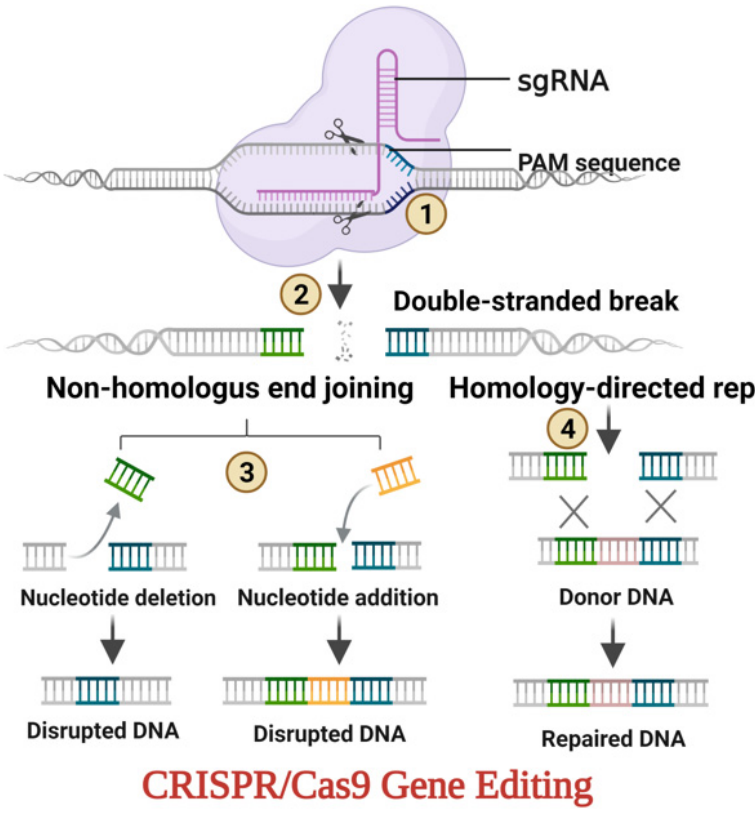
Figure 3. Overview of CRISPR-Cas9 mediated gene editing. ① A complex of CRISPR-Cas9 genetic scissors and artificially constructed single guide RNA (sgRNA) scans DNA and traces code where a cut has to be made. ② Formation of non-homologous end-joining (NHEJ) and homology direct repair (HDR) strands after DNA double-strand break (DSB). ③ Ligation of the DNA DSB by nucleotides addition on the right and deletion on the left result in gene disruption. ④ Repairing the DSB in HDR by employing an externally provided homologous DNA template for copying. The donor template’s DNA sequence is duplicated at the targeted site, which results in a guided repair.